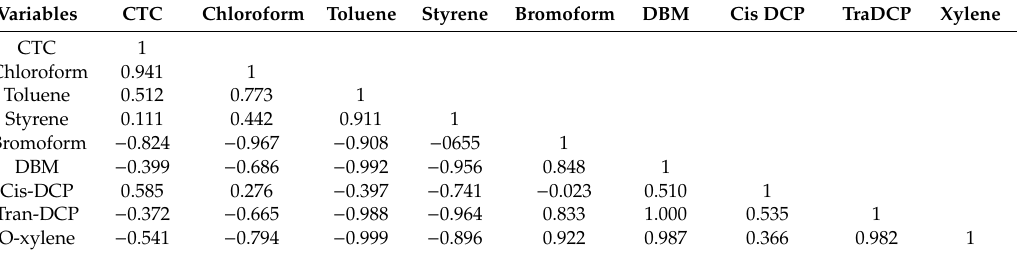
Table 8. Correlation matrix Pearson (n) for VOCs leached from plastic